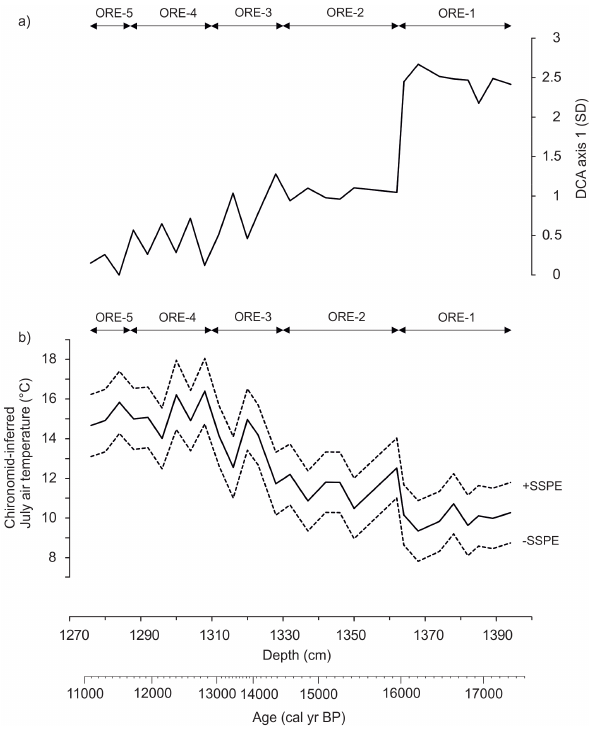
Fig. 4. (a) Sample scores of the first DCA (detrended correspon- dence analysis) axis of the chironomid assemblages plotted ver- sus sediment depth and age, and (b) chironomid-inferred July air temperatures estimated based on a weighted averaging partial least squares model using the Swiss–Norwegian modern training set (Heiri et al., 2011) (including sample specific error of prediction: